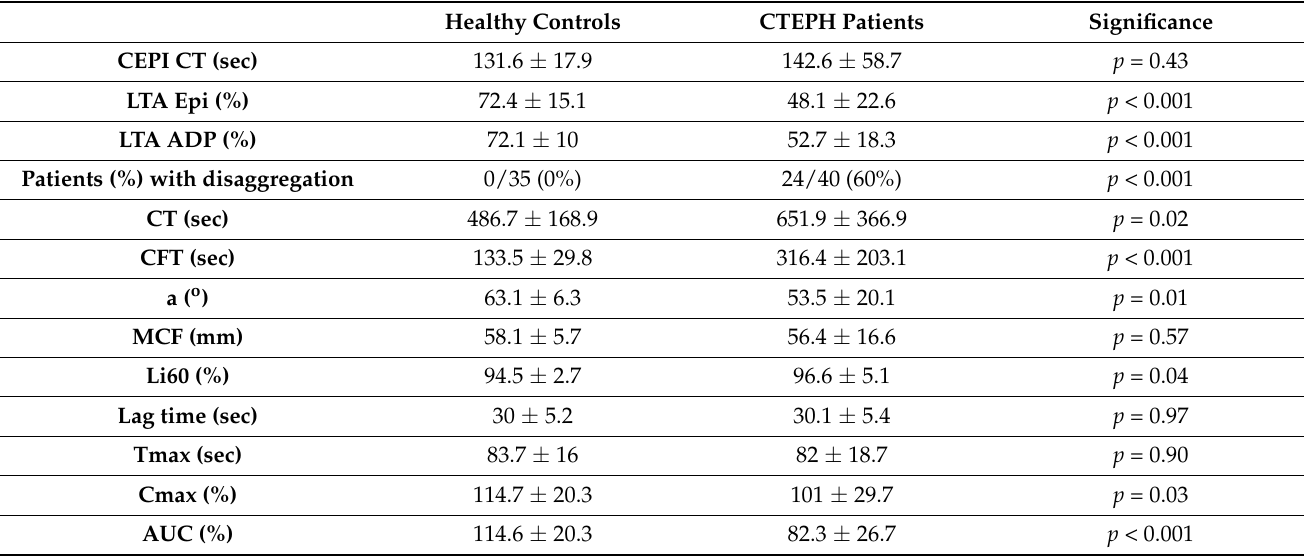
Table 3. Platelet and coagulation parameters in CTEPH patients and healthy controls.